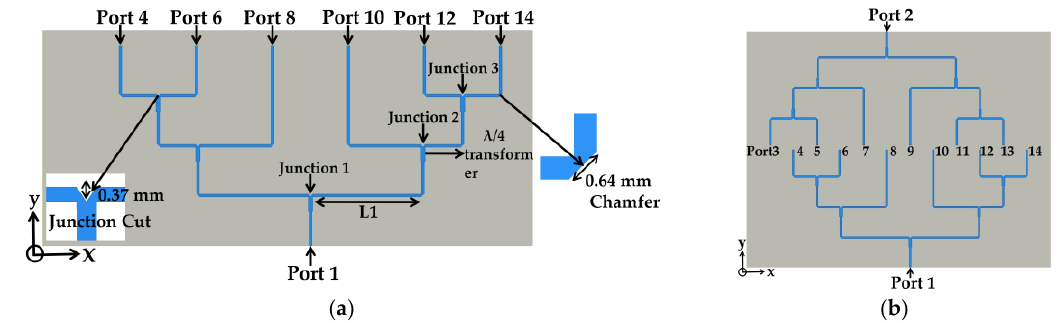
Figure 4. ( a ) one-to-six way non-uniformly powered and uniformly spaced power divider. ( b ) Two